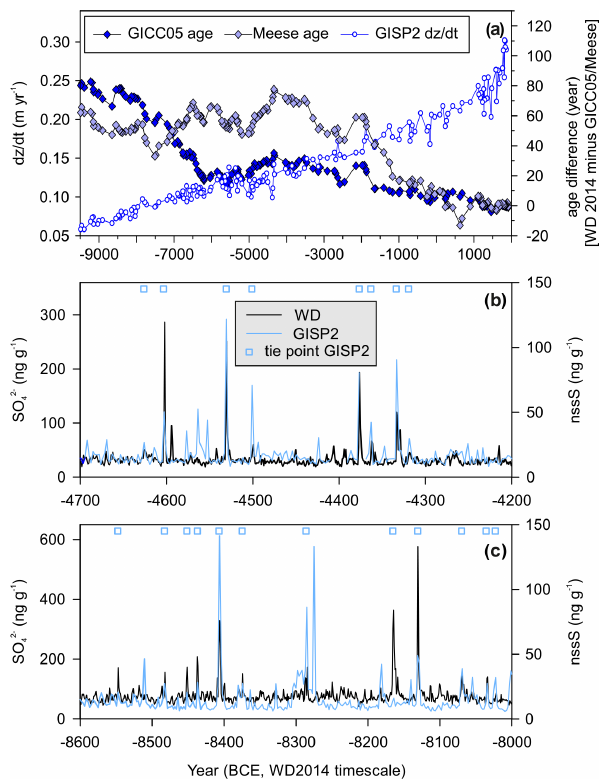
Figure 2. Bipolar volcanic synchronization: panel (a) shows the changes in mean annual layer thickness (d z/ d t ) and age differ- ences (WD2014 minus GICC05 – Vinther et al., 2006; WD2014 minus GISP2 annual-layer-counted timescale – Meese et al., 1997) calculated between volcanic tie points for the GISP2 ice core; panel (b) shows the WD non-sea-salt sulfur (nssS) record as well as the GISP2 sulfate record for the 4700–4200BCE time period and volcanic tie points used for the synchronization; panel (c) shows the same records for the 8600–8000BCE time period. All records are shown on the WD2014 chronology (Sigl et al., 2016).